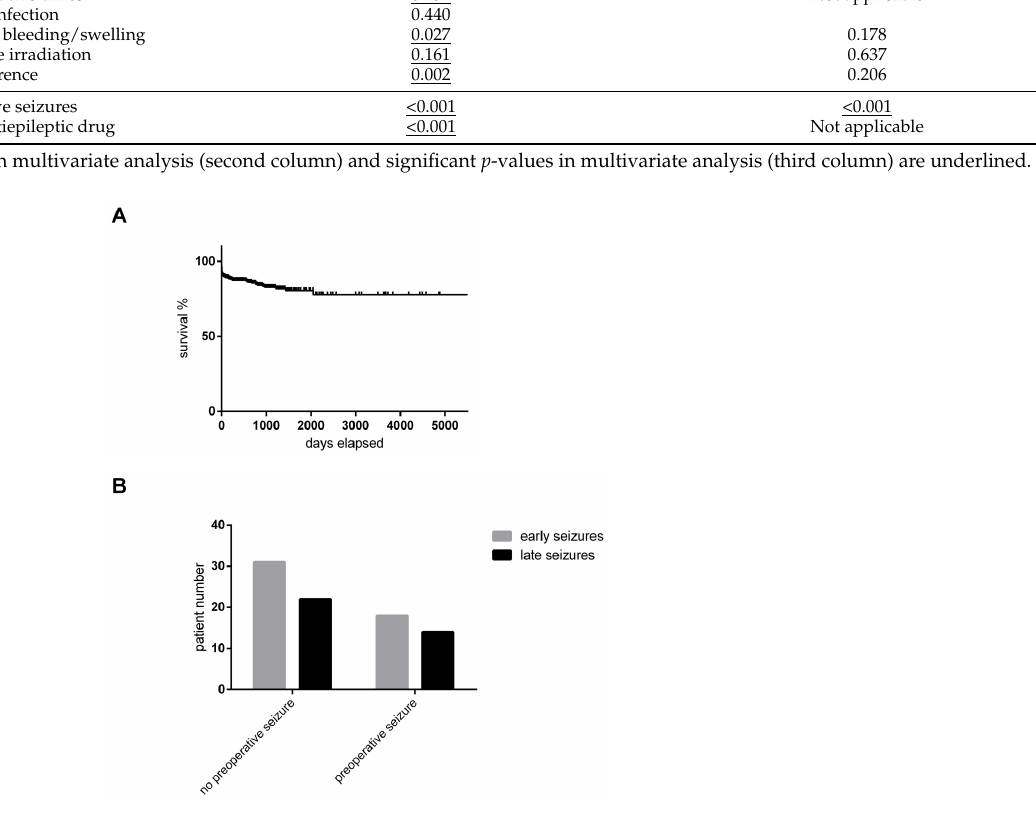
0.8396; Pearson: p =